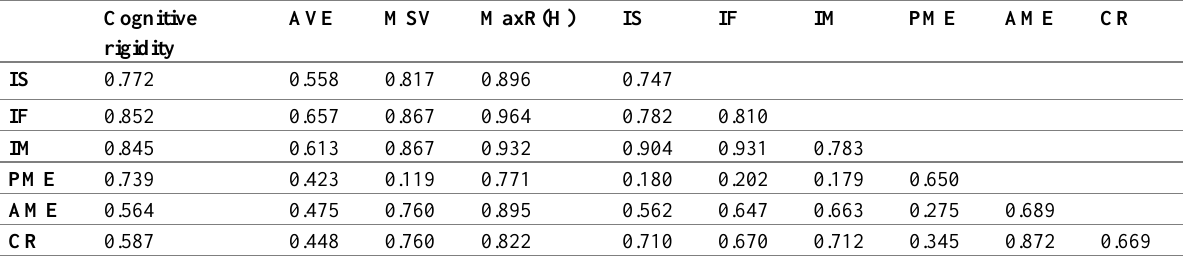
Table 2: Discriminant and Convergent